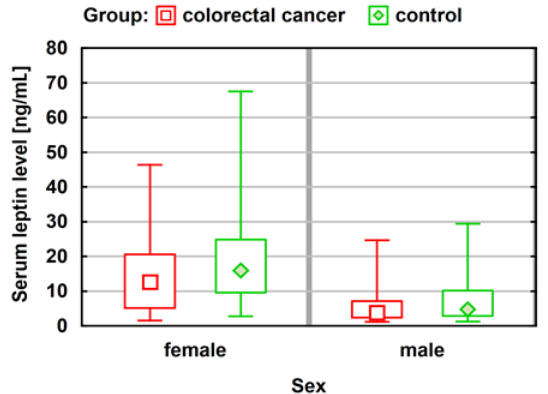
Figure 5. Comparison of leptin concentration in the study and comparison groups. Study group ( n = 61); control group ( n = 60). Statistical analysis was performed using the Kruskal-Wallis test and the Mann-Whitney test; p -value < 0.05.